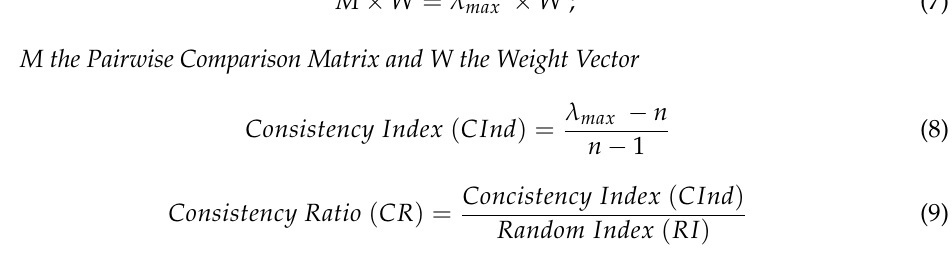
Table 4. Random indices (RI) from randomly generated matrices based on Duleba and Moslem [56].